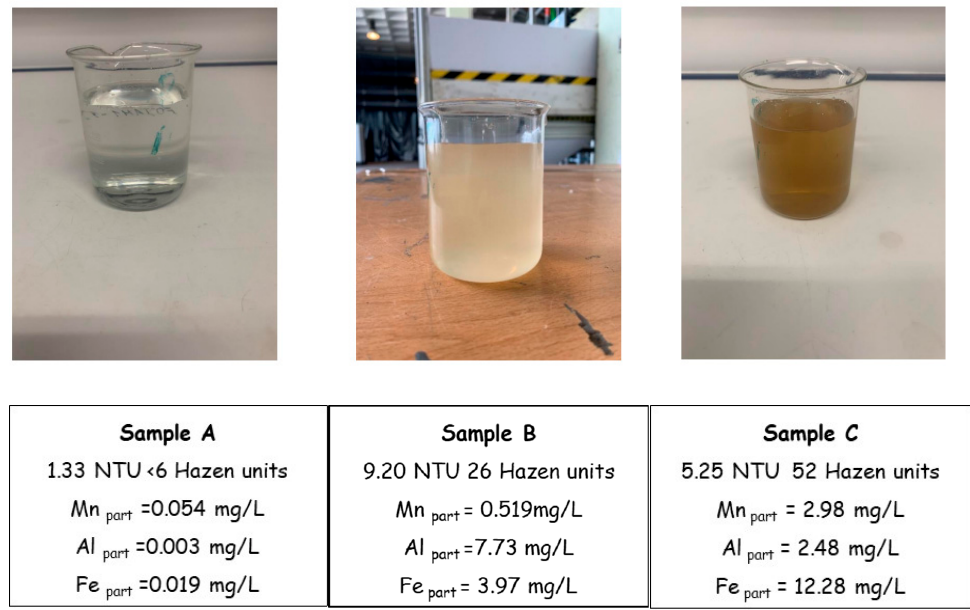
Figure 6. Color appearance of collected samples; color vs. turbidity.